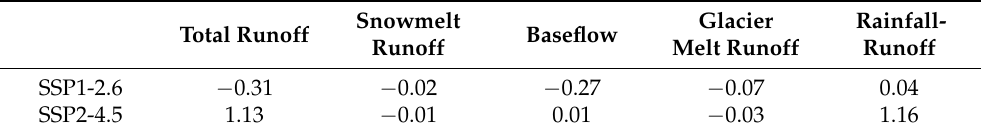
Figure 13. Yearly average baseflow (Q BF ), glacier melt runoff (Q GR ), rainfall-runoff (Q RR ), snowmelt runoff (Q SR ), and total runoff (Q TR ) simulated by SPHY of the Lhasa River under SSP1-2.6 and SSP2-4.5. Table 5. Change rate of total runoff, snowmelt runoff, baseflow, glacier melt runoff, and rainfall runoff (m 3 /s/year).